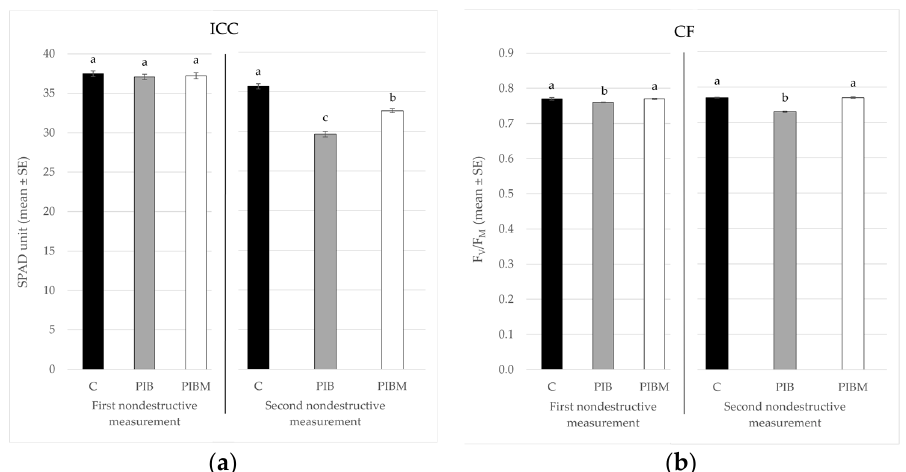
Figure 2. Mean values (±SE) of ( a ) the indirect chlorophyll content (ICC) and ( b ) the chlorophyll fluo-